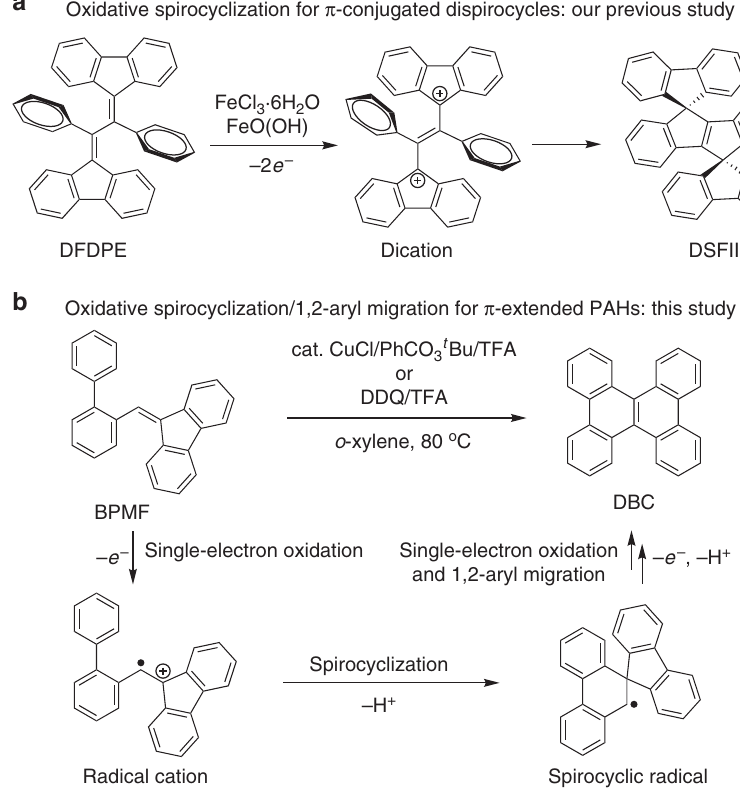
Figure 1 | Single-electron oxidation of alkenes for synthesis of p -conjugated polycyclic hydrocarbons. ( a ) Our previous method for synthesis of dispirofluorene-indenoindenefluorene (DSFIIF) via FeCl 3 -promoted oxidative spirocyclization of 1,2-di(9 H -fluoren-9-ylidene)-1,2-diphenylethane (DFDPE). ( b ) This study for the single-electron oxidation induced spirocyclization and 1,2-aryl migration tandem synthesis of PAHs. 2 NATURE COMMUNICATIONS|8:15073|DOI: